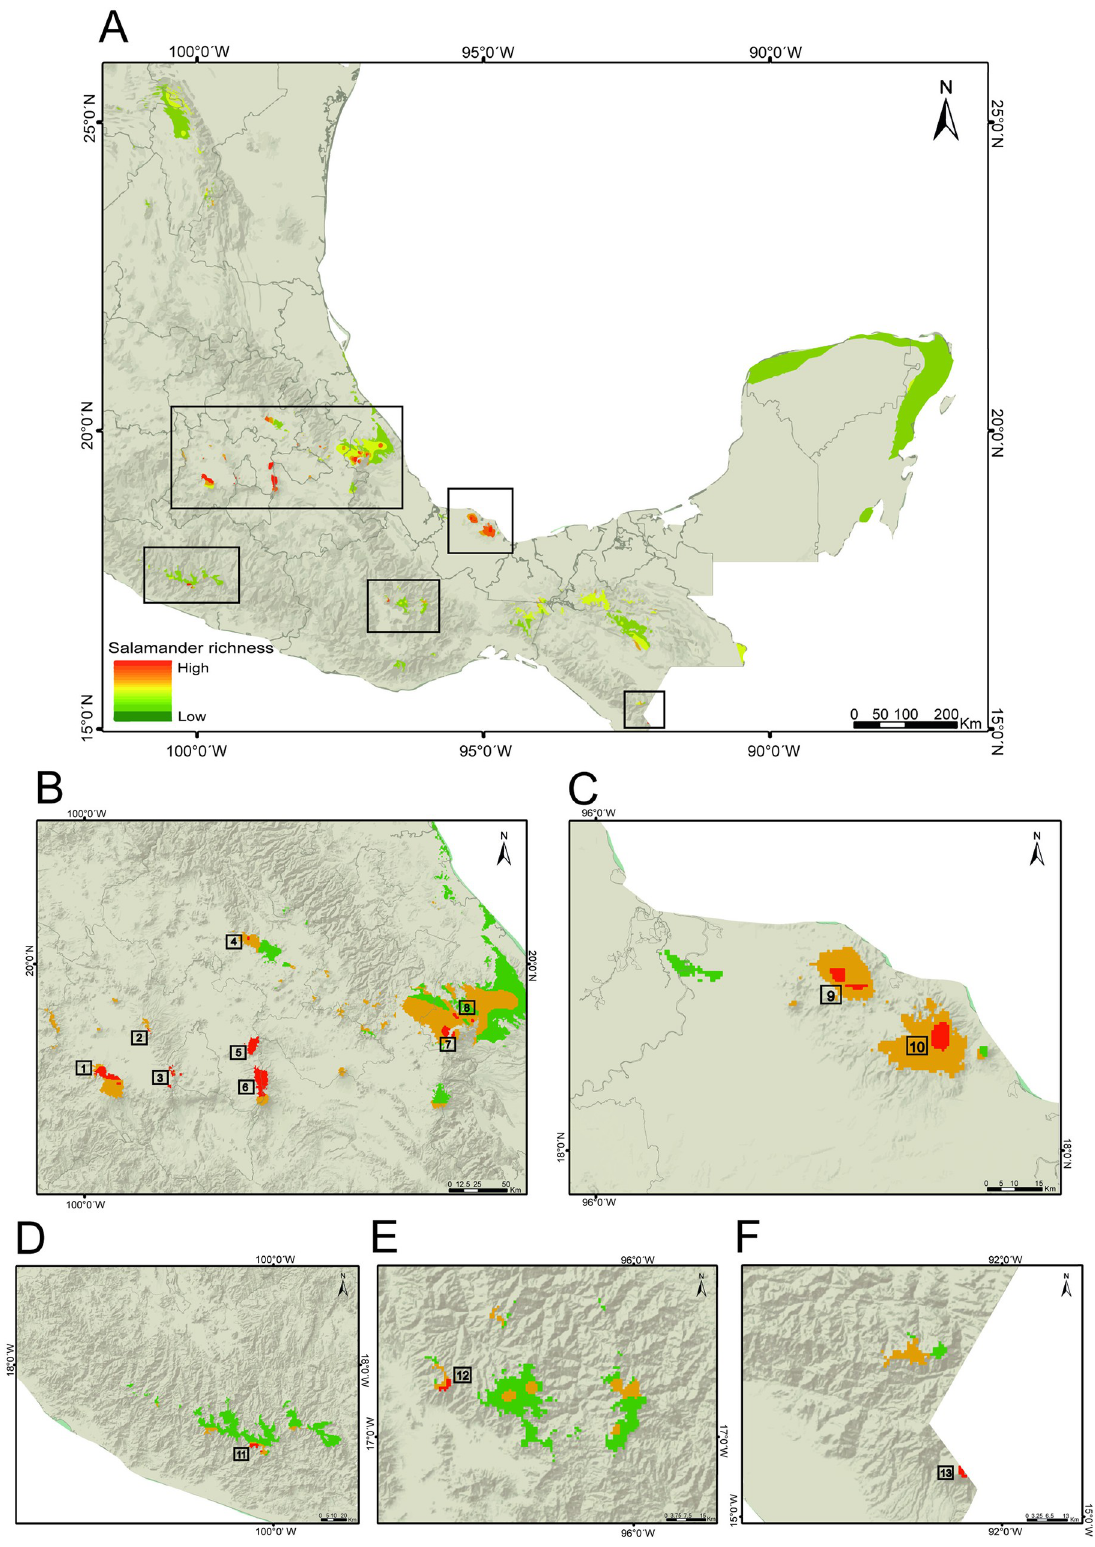
Fig 3. Overlap of salamander richness with moderate suitable and high suitable areas for Bsal. (A) Areas with hotspots. Hotspots identification in: (B) TVB. (C) Los Tuxtlas. (D) SMS in Guerrero. (E) Northern Oaxaca. (F) SMS in Chiapas. https://doi.org/10.1371/journal.pone.0211960.g003 PLOS ONE | https://doi.org/10.1371/journal.pone.0211960 February 12,